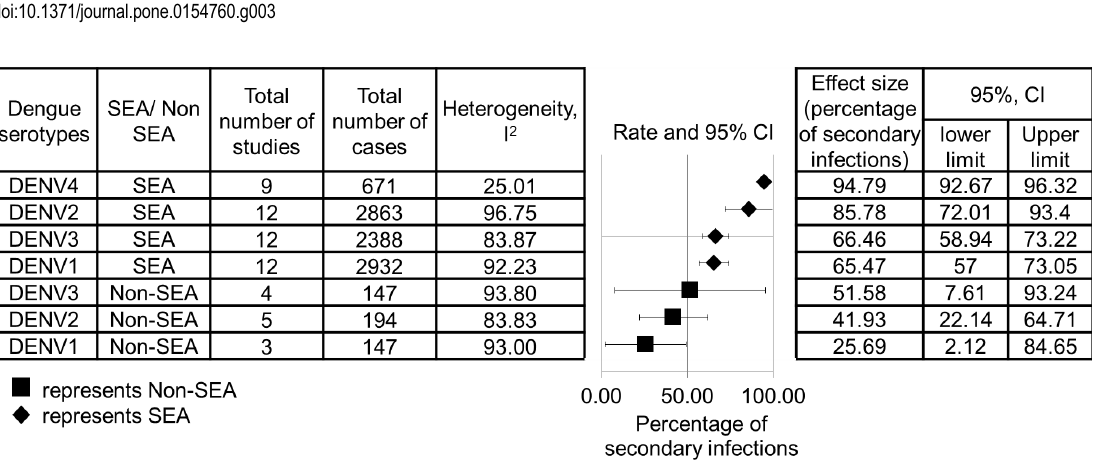
Fig 4. Pooled effect size of the relationship between dengue serotypes and secondary infection. The data are separated by SEA and non-SEA regions.